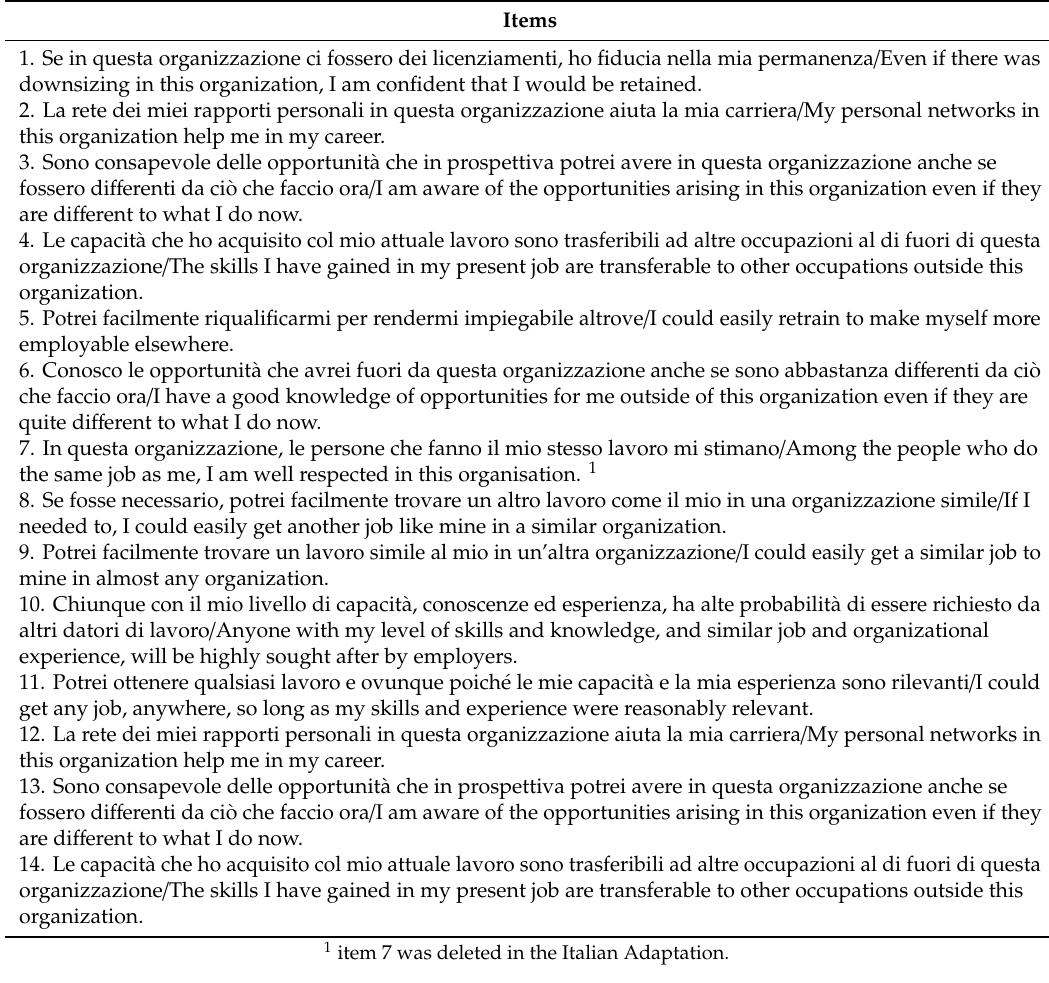
Table A1. Italian adaptation / English original version of Self-Perceived Employability